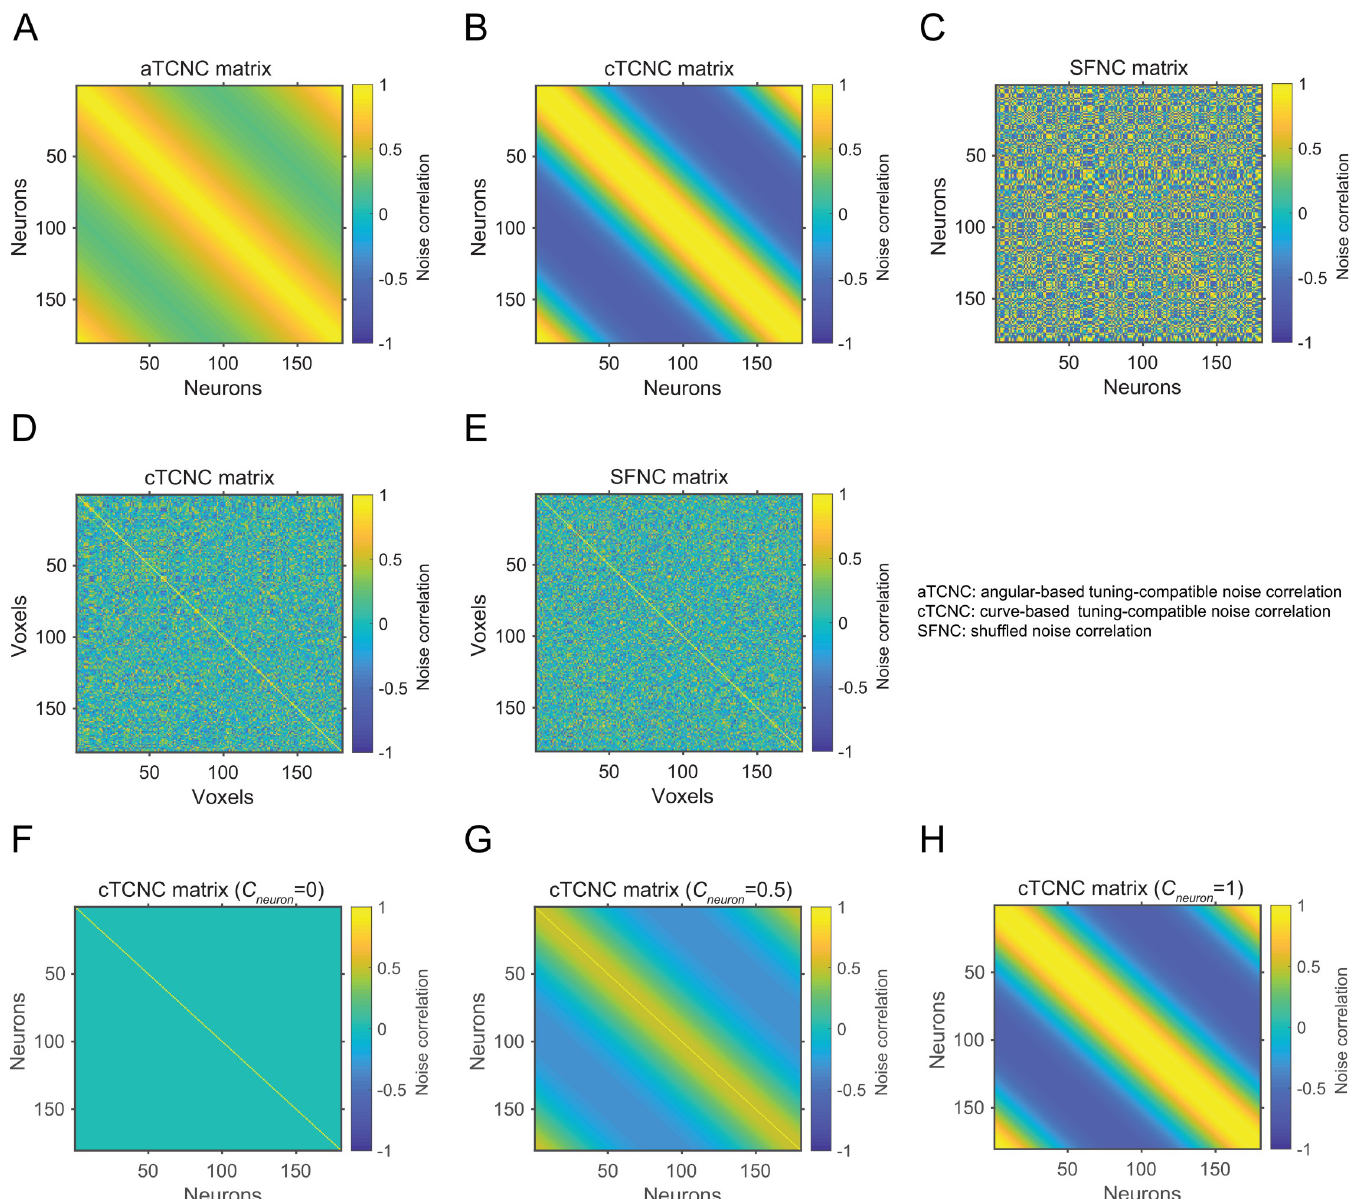
Fig 3. Example noise correlation matrices simulated in a neuronal (panels A-C) and a voxel population (D, E). In the neuronal population (180 neurons), the angular- based TCNC matrix, the curve-based TCNC matrix, and the SFNC matrix are illustrated from left to right. Neurons are sorted according to their preferred orientation from 1 to 180˚. In the voxel population (180 voxels), the curve-based TCNC matrix and the SFNC matrix are illustrated. Note that we do not sort the voxels according to their tuning preferences. The NC coefficients ( c neuron or c vxs ) are set to 1 in matrices from A-E. Panels F-H illustrate the cTCNC matrices with NC coefficient ( c neuron ) values 0, 0.5 and 1, respectively. Note that panels B and H are